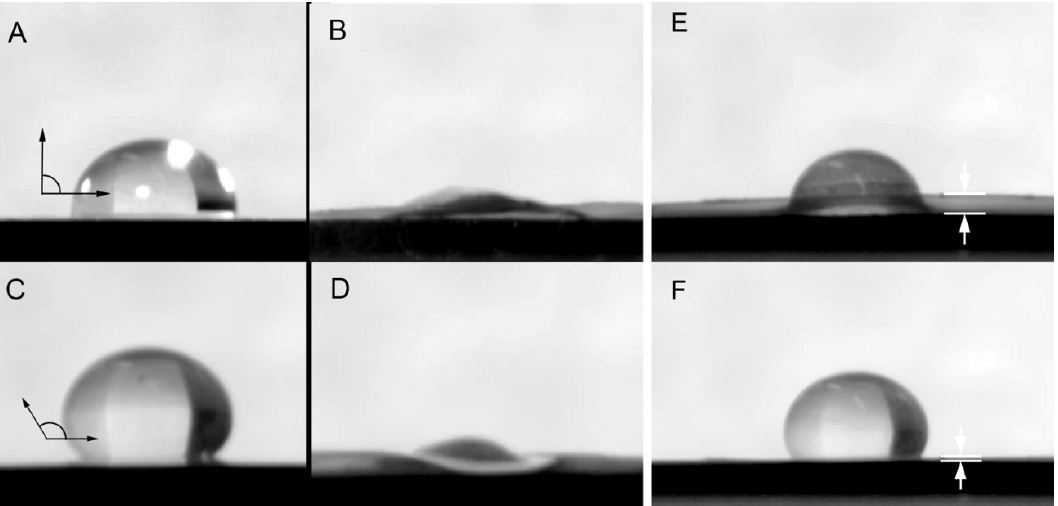
Figure 2. Measurement of contact angle and fractional thickness variation. ( A ) The water contact angle with progressive evaporation and absorption ( B ). ( C ) Pleural fluid contact angle with progressive evaporation and absorption ( D ). Associated with water ( E ) or pleural fluid ( F ) absorption was an increase in fractional thickness of the pectin film (white arrows).